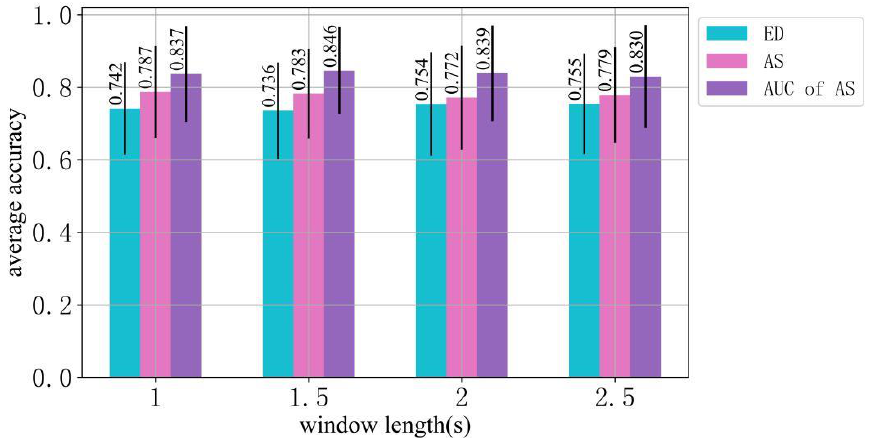
Figure 8. The comparison of the average classification accuracy and AUC value distribution using the ED and AS algorithms for the features extracted from six cropped windows (n = 6), each of which is 1 s/1.5 s/2 s/2.5 s in length.